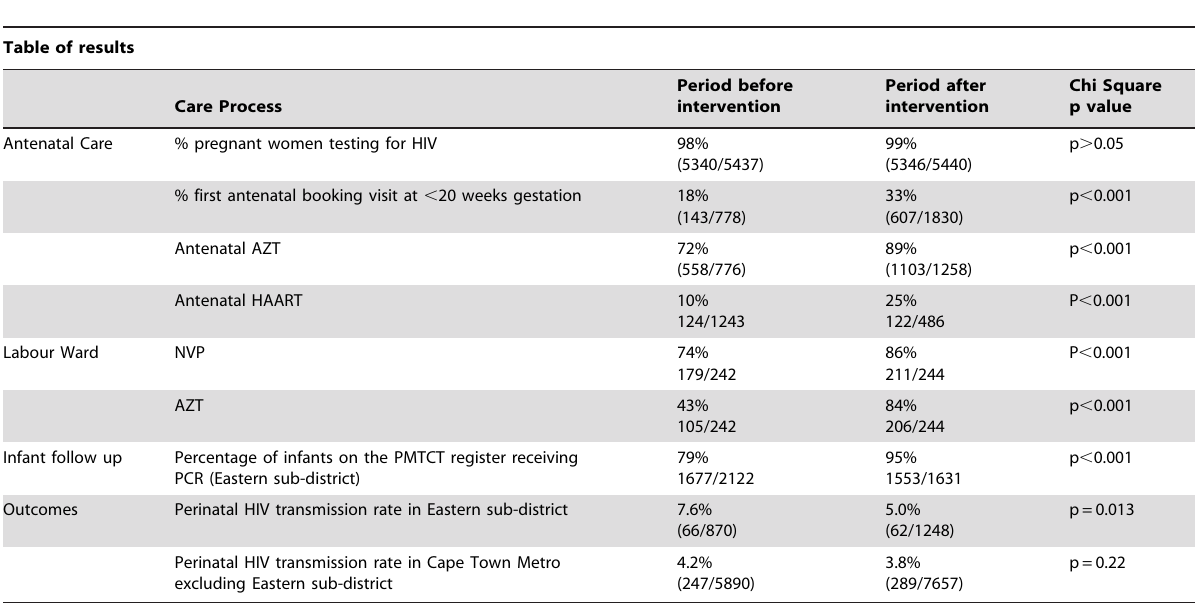
Table 2. Summary of PMTCT process and outcome results.